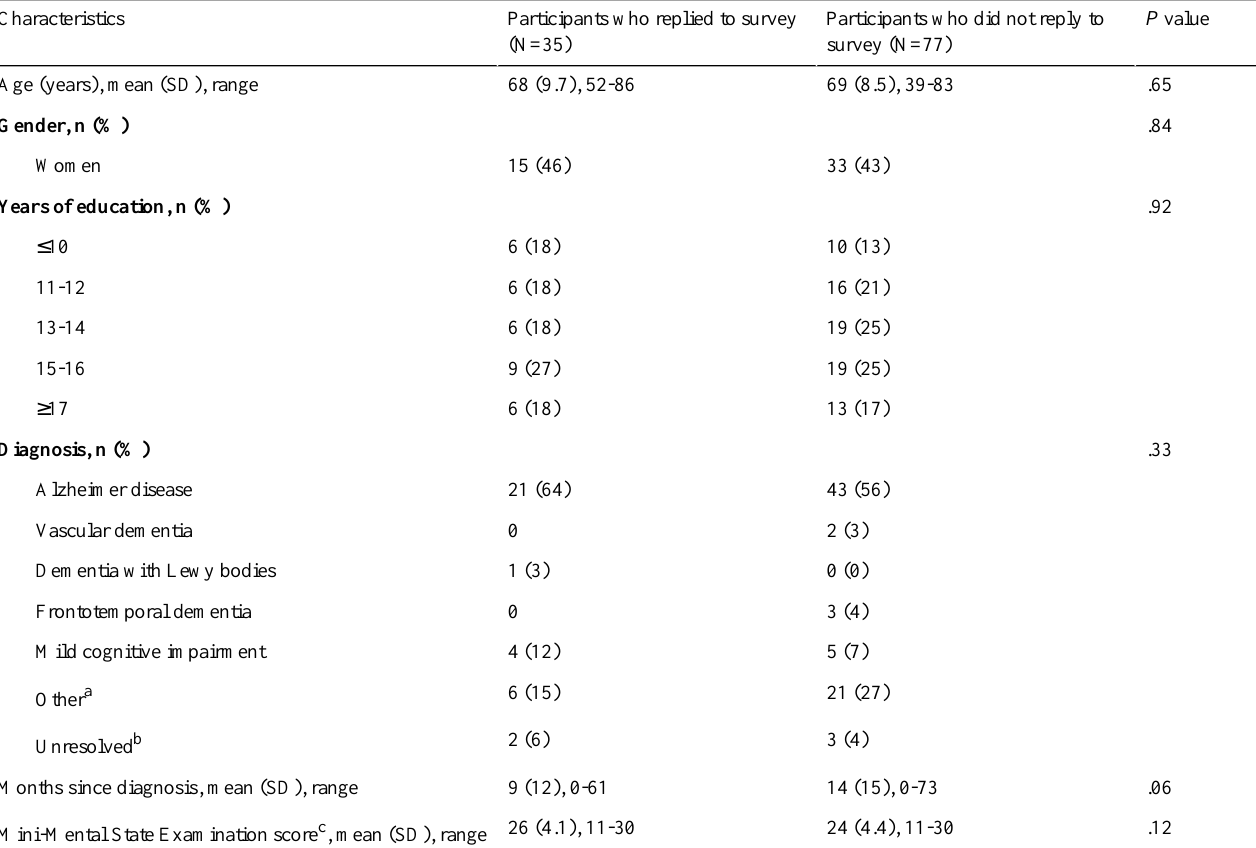
Table 4. Baseline characteristics of participants who replied to the survey compared with participants who did not reply to the survey.